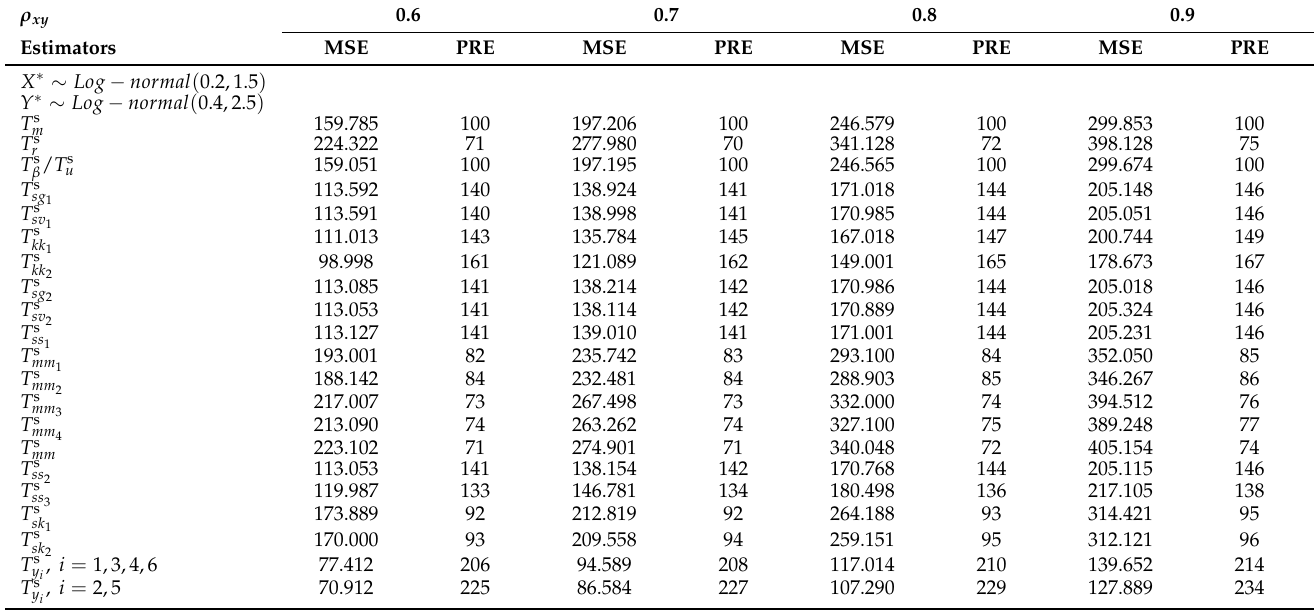
Table 9. MSE and PRE of separate estimators utilizing hypothetically drawn Log-normal